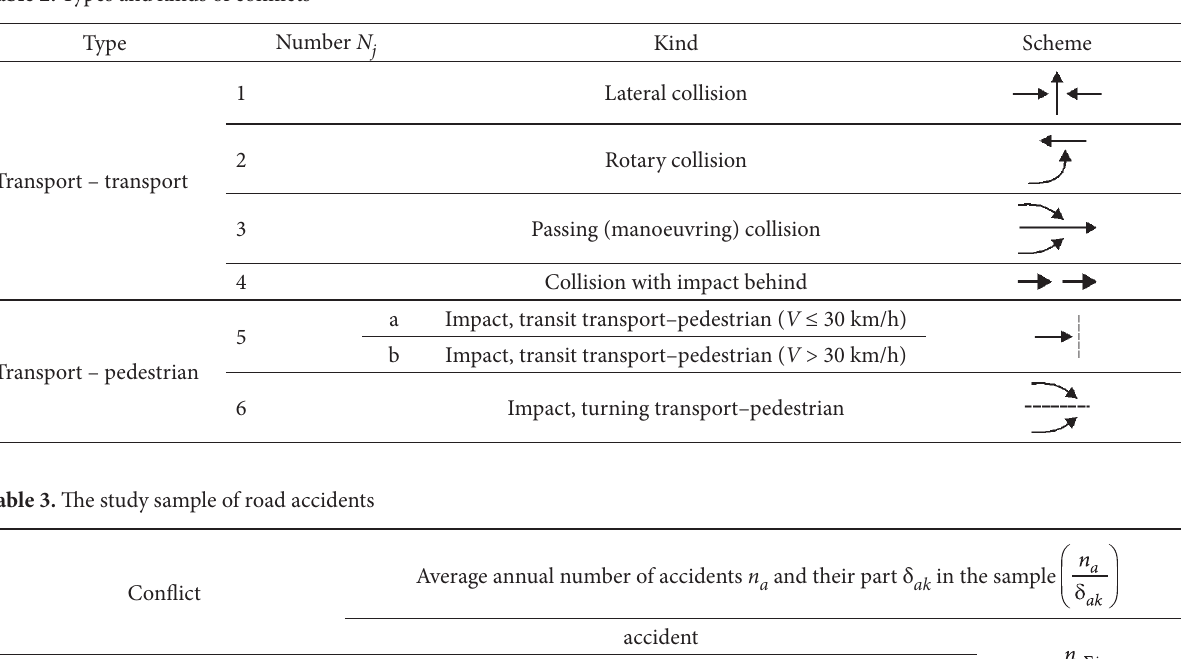
Table 2. Types and kinds of conflicts